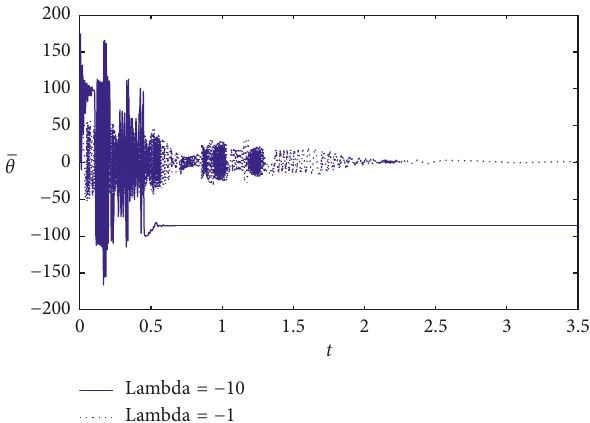
Figure 6: The time response of state θ of system (29) with , x ,x x 1 ( 0 ) (cid:26) 5 2 ( 0 ) (cid:26) 0 3 ( 0 ) (cid:26) − 4.